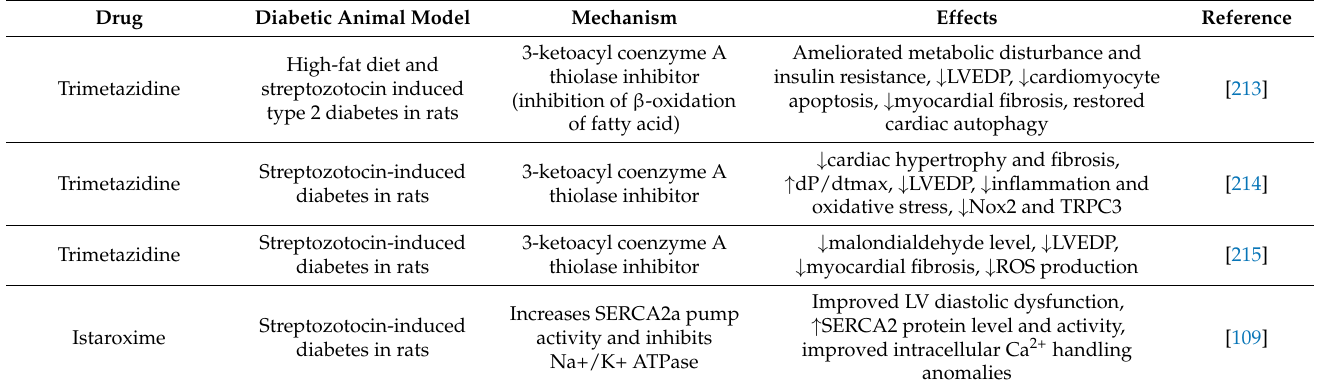
Table 3. Effective treatment of diabetic cardiomyopathy in preclinical